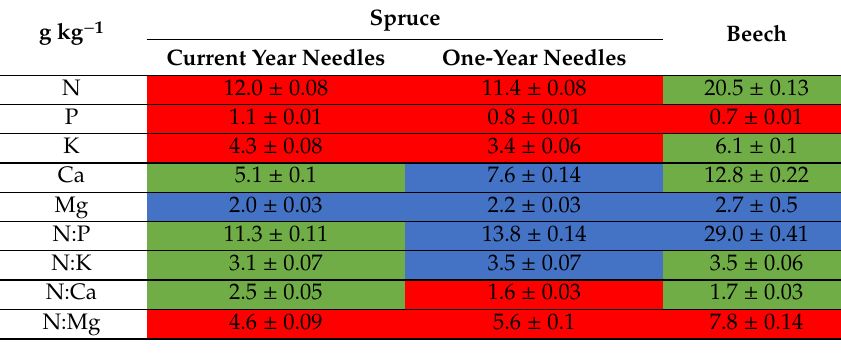
Table 2. Mean ± SE of tree foliage concentrations in Norway spruce and European beech at Zöbelboden (years 1992 to 2019). Nutrient deficiency or surplus according to [44] is given as red = deficient, green = normal, blue = surplus, and critical nutrient ratio levels as red = below limit, green = within limits, blue = above limit. Spruce g kg − 1